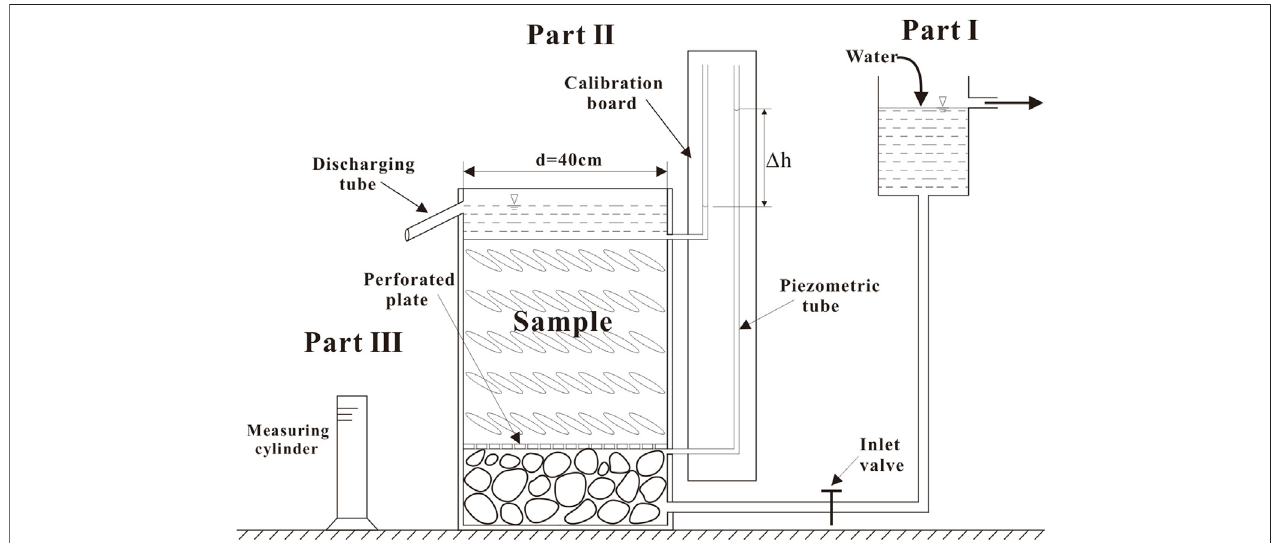
FIGURE 3 | Schematic diagram of large-scale permeability